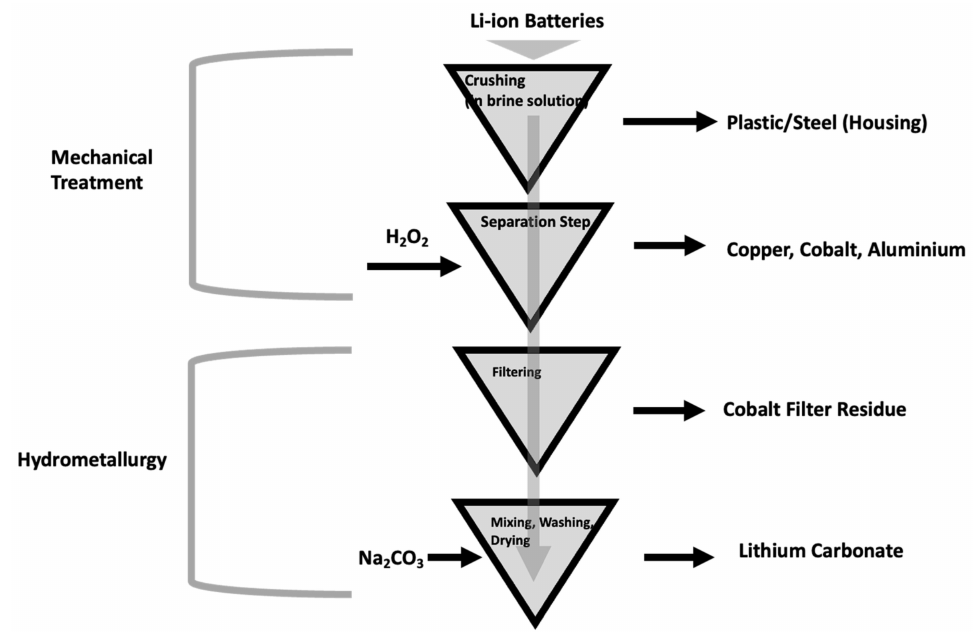
Figure 15. Toxco process flow diagram (Data derived from refs.